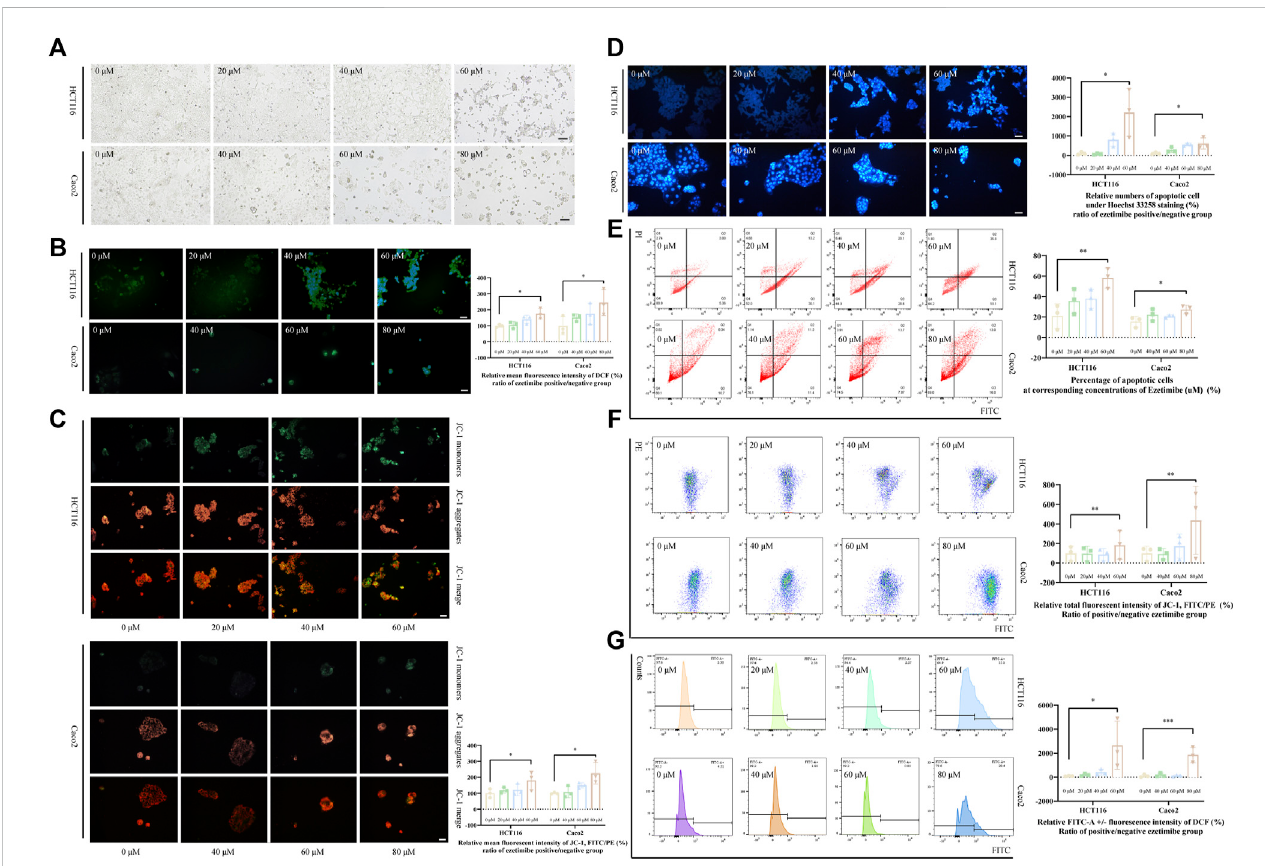
FIGURE 2 EzetimibepromotestheCRCcelldeathwithmitochondrialdysfunction. (A) MorphologicalchangesofHCT116andCaco2cellsundergradientezetimibe treatment at 48 h. (B) Fluorescence intensity of DCF in gradient ezetimibe treated HCT116 and Caco2 cells with microscopic observation. Scale bar, 100 μ M. (C) Fluorescence intensity of JC-1 in gradient ezetimibe treated HCT116 and Caco2 cells with microscopic observation. Scale bar, 100 μ M. (D) Apoptosis of HCT116 and Caco2 cells under gradient ezetimibe treatment with hoechst33258 staining. Scale bar, 100 μ M. (E) Apoptosis of HCT116 and Caco2 cells under gradient ezetimibe treatment with Annexin V-FITC/PI staining fl ow cytometry. (F) Fluorescence intensity of JC-1 in gradient ezetimibe treated HCT116 and Caco2 cells with fl ow cytometry. (G) Fluorescence intensity of DCF in gradient ezetimibe treated HCT116 and Caco2 cells with fl ow cytometry. * p < 0.05, ** p < 0.01, *** p <